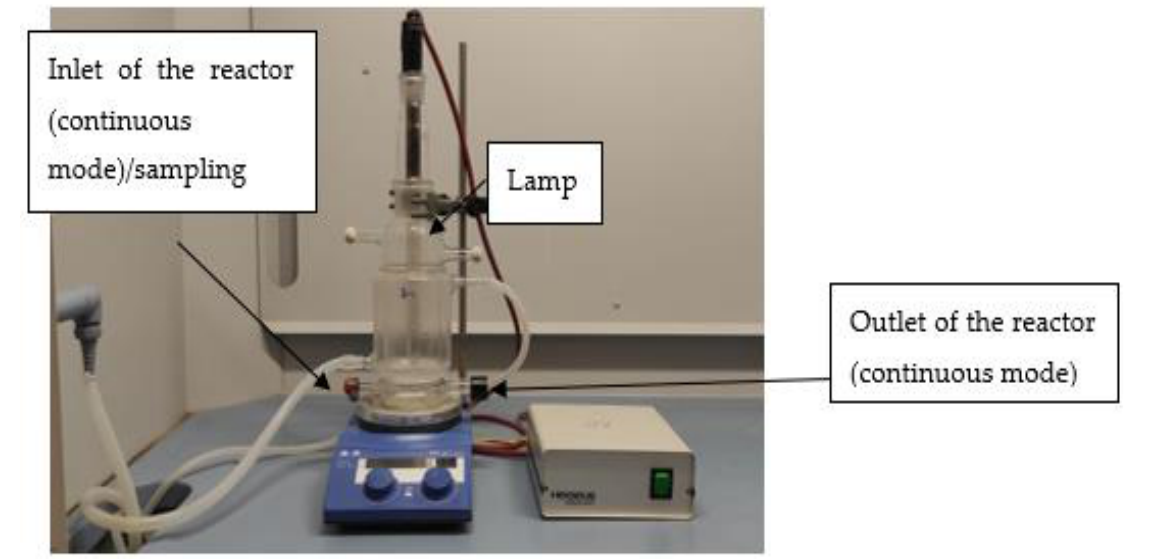
Figure 1. Experimental set-up employed in this work.